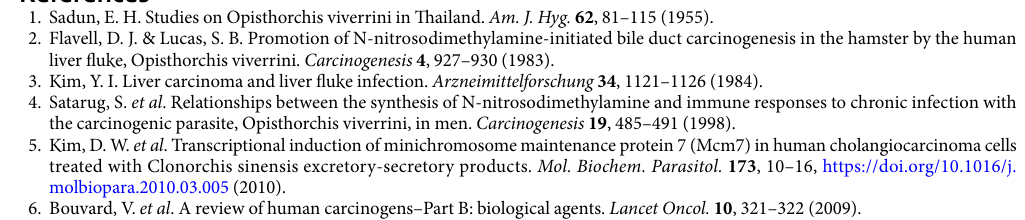
The electrostatic field and normalized temperature factor of proteins were calculated and visualized using PyMol 48 . All images describing the structures of proteins were made using PyMol 48 . Catalytic activity measurement. The catalytic activity of wild-type OvTIM and Δ SAD variant to isomer- ase DHAP to GAP was measured using triose phosphate isomerase activity colorimetric assay kit (BioVision) 49,50 . Absorbance at 450 nm was plotted to NADH concentration for standard curve after seven NADH solutions which range from 0.05 mM to 0.4 mM were incubated with enzyme mix and developer for 10 mins. The absorbance of reaction mixtures containing 0.4 mM DHAP and 0.018 mM OvTIM dimer was recorded at 450 nm in every 10 secs. Total 2 sets of activity curves of wild-type OvTIM and Δ SAD variant were obtained and plotted after con- version of the absorbance to NADH concentration based on previously determined standard curve.